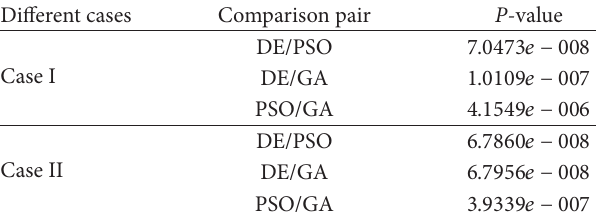
Table 6: 𝑃 values for Wilcoxon’s two sided rank sum